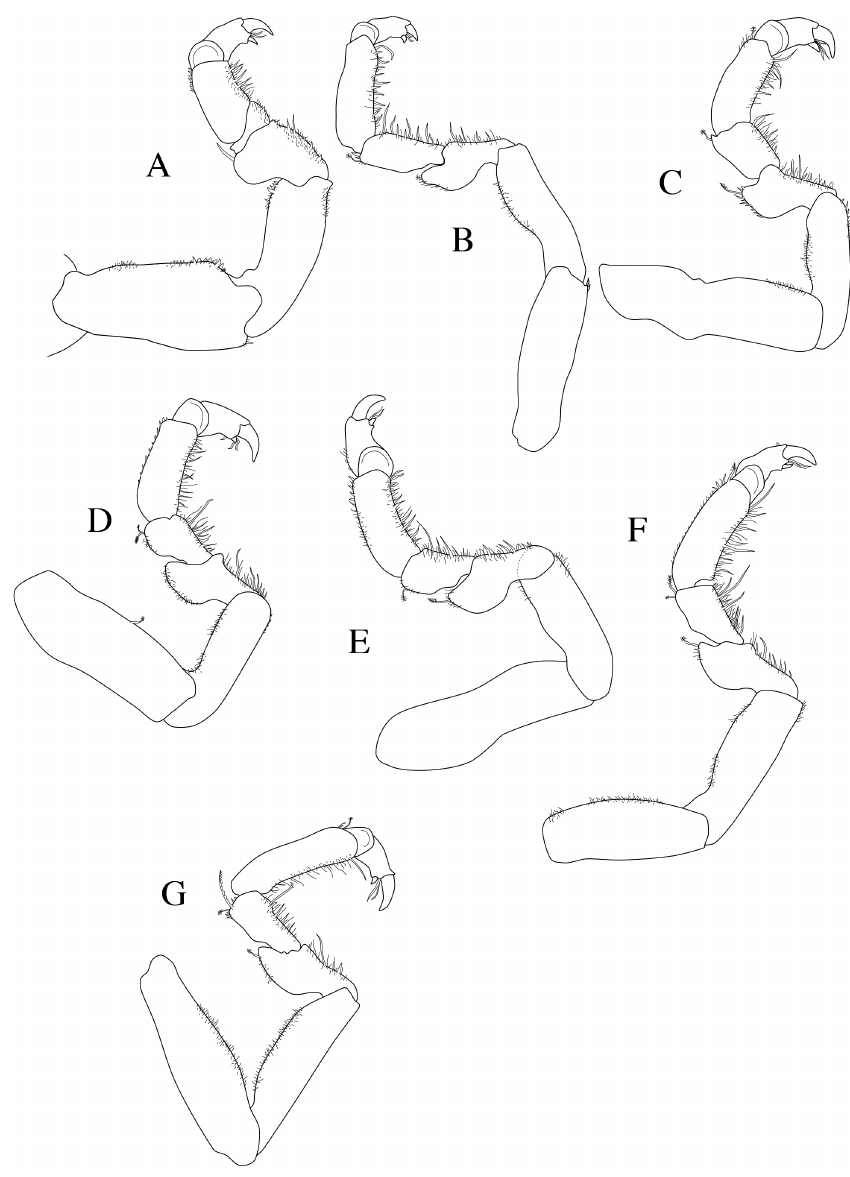
Figure 3. Dynoides elegans . ♂ Paratype. USNM 1422085. All appendages from left. A pereopod 1 B pereopod 2 C pereopod 3 D pereopod 4 E pereopod 5 F pereopod 6 G pereopod